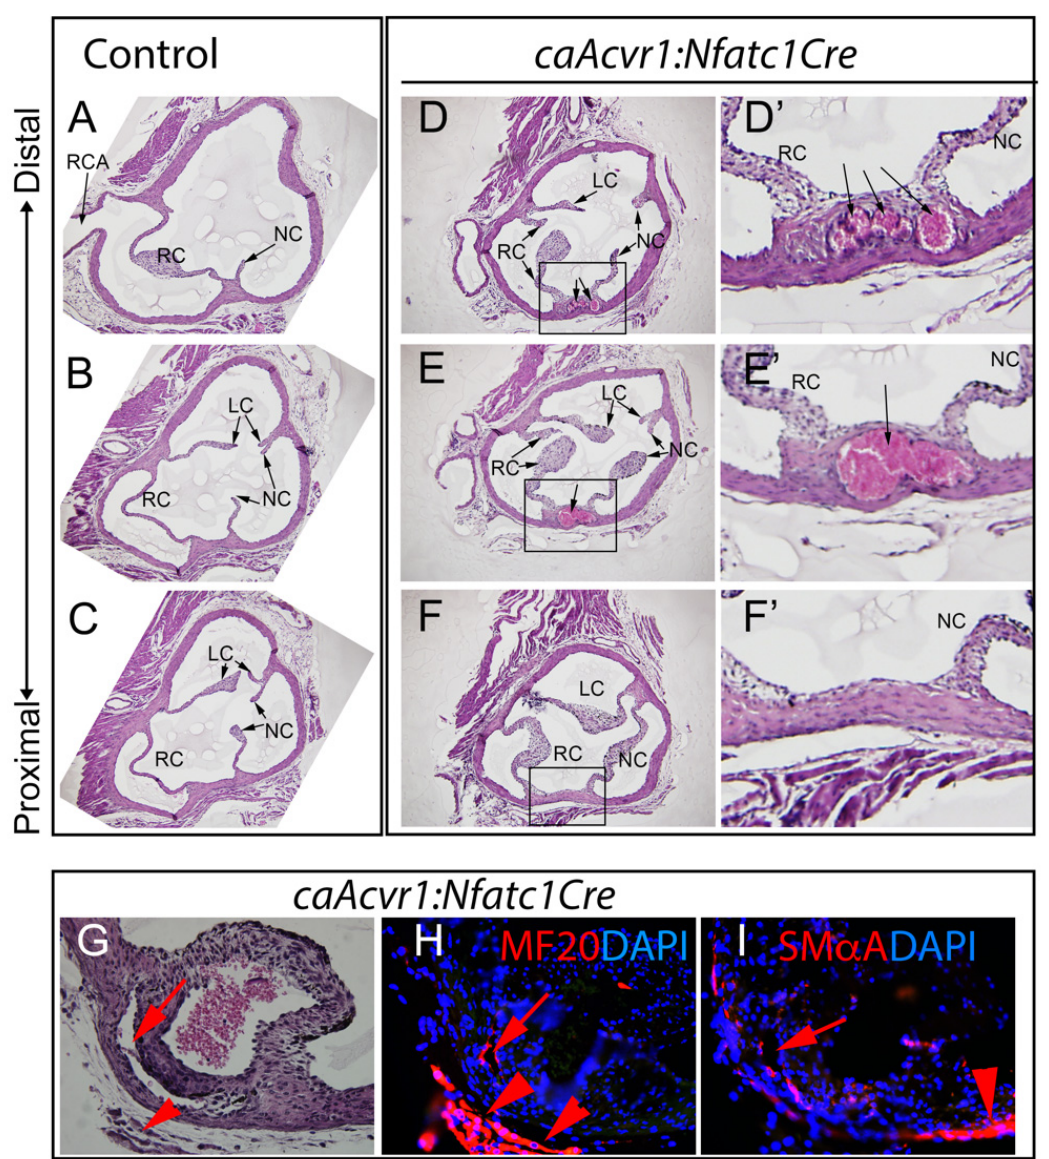
Figure 3. Enhanced AcvRI signaling led to thickened aortic valve leaflets and aortic wall defects. Histological sections of the control ( A – C ) and mutant ( D – F ) samples (four months old) depicting the aortic valve leaflets (proximal-to-distal) in a transverse orientation. LC, left coronary; RC, right coronary; NC, non-coronary. ( D’ – F’ ) High-power images depicting the aortic wall lesions (boxed areas in ( D – F )). Black arrows in ( D , E ) (boxed area) and ( D’ , E’ ) point to the filled sinuses seen in the mutants. ( G – I ) Aortic wall defects in the caAcvr1:Nfatc1Cre mutants. ( G ) H&E staining. ( H ) MF20 immunostaining. ( I ) Sm α A immunostaining. Red arrows in ( G – I ) point to aberrant sinuses; red arrowheads in ( G – I ) point to adjacent myocardium. ( H , I ) Counterstaining with DAPI (blue).